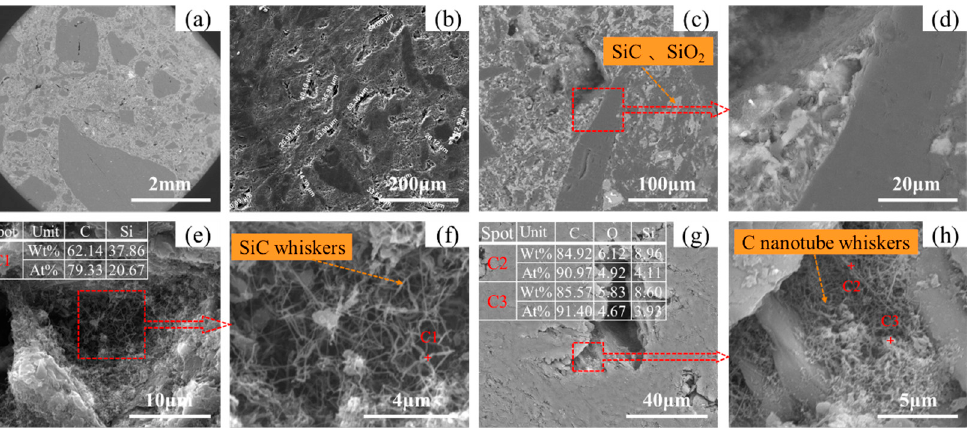
Figure 9. ( a – h ) Microscopic morphology of the original brick C under different scaleplates.